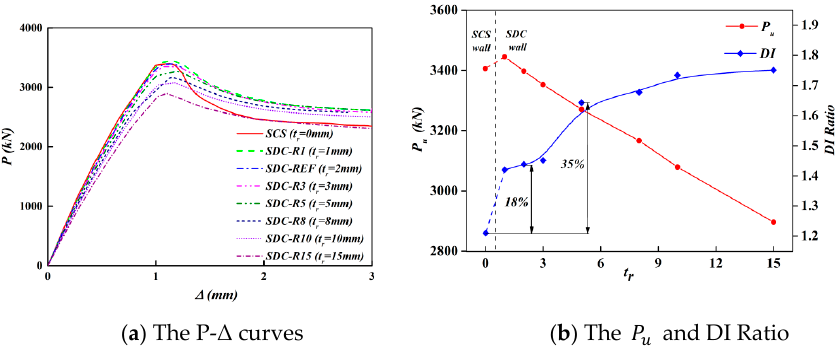
Figure 15. Influence of thickness of rubber layer on compressive resistance of SDC wall.